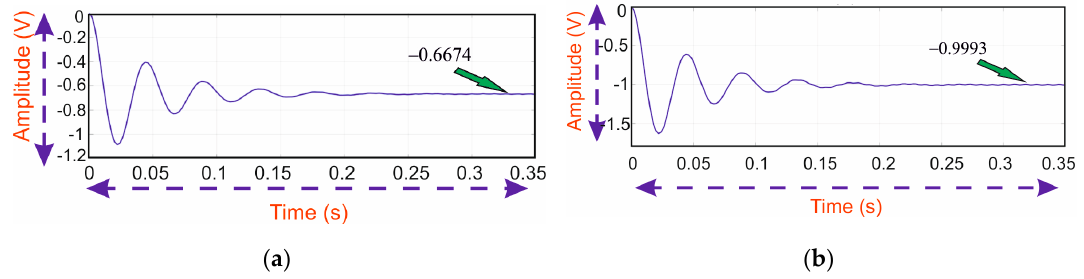
Figure 10. Step response of open loop system ( a ) with V 1 source and ( b ) with V 2 source.